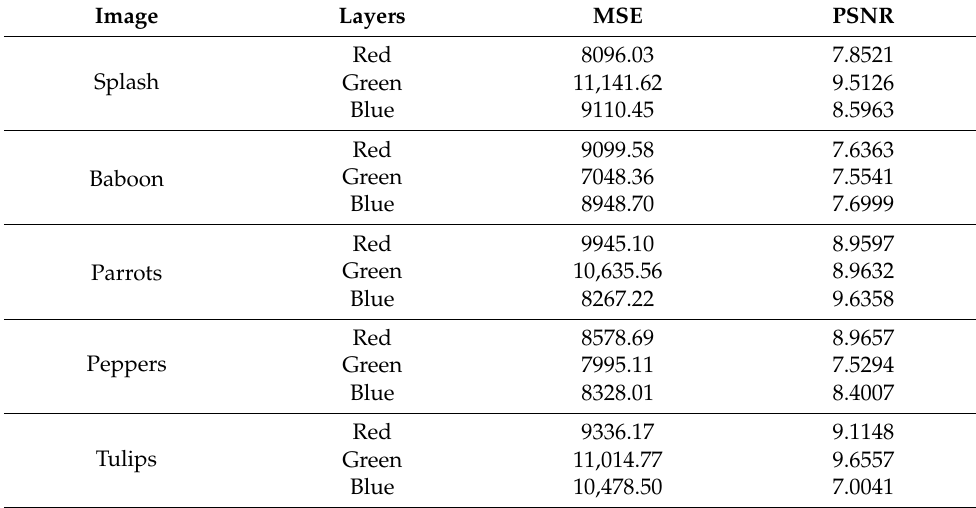
√ means test is passed.